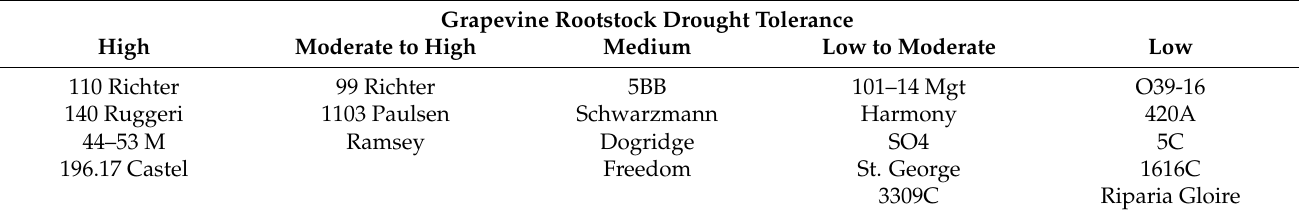
Table 2. Grapevine rootstocks: degrees of drought tolerance. Grapevine Rootstock Drought